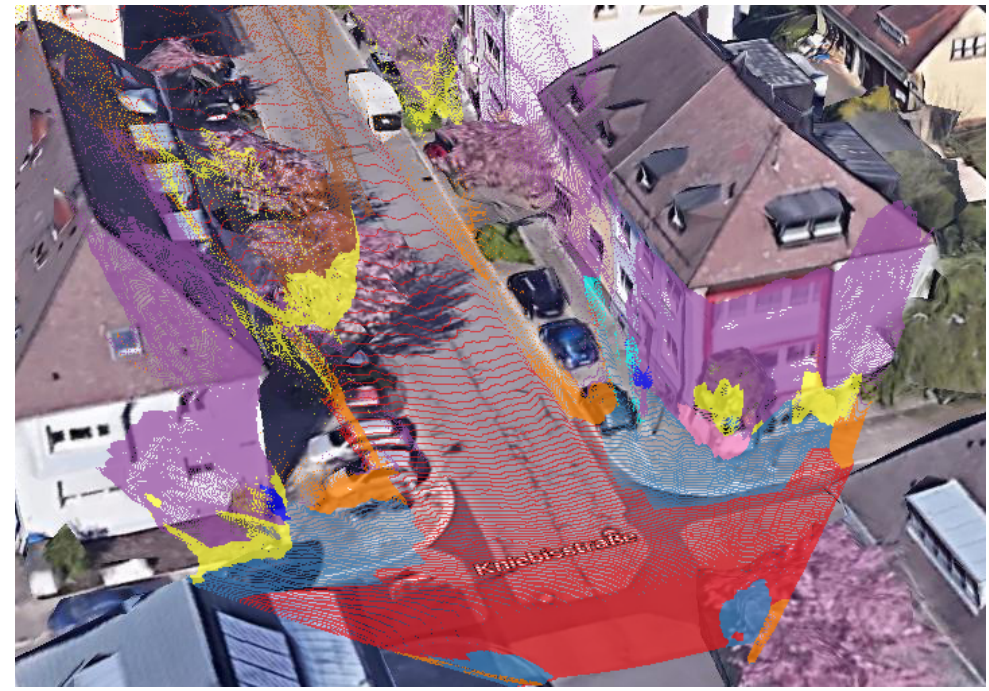
Figure 1. A map with the 3D buildings overlaid with the Point Clouds generated with our